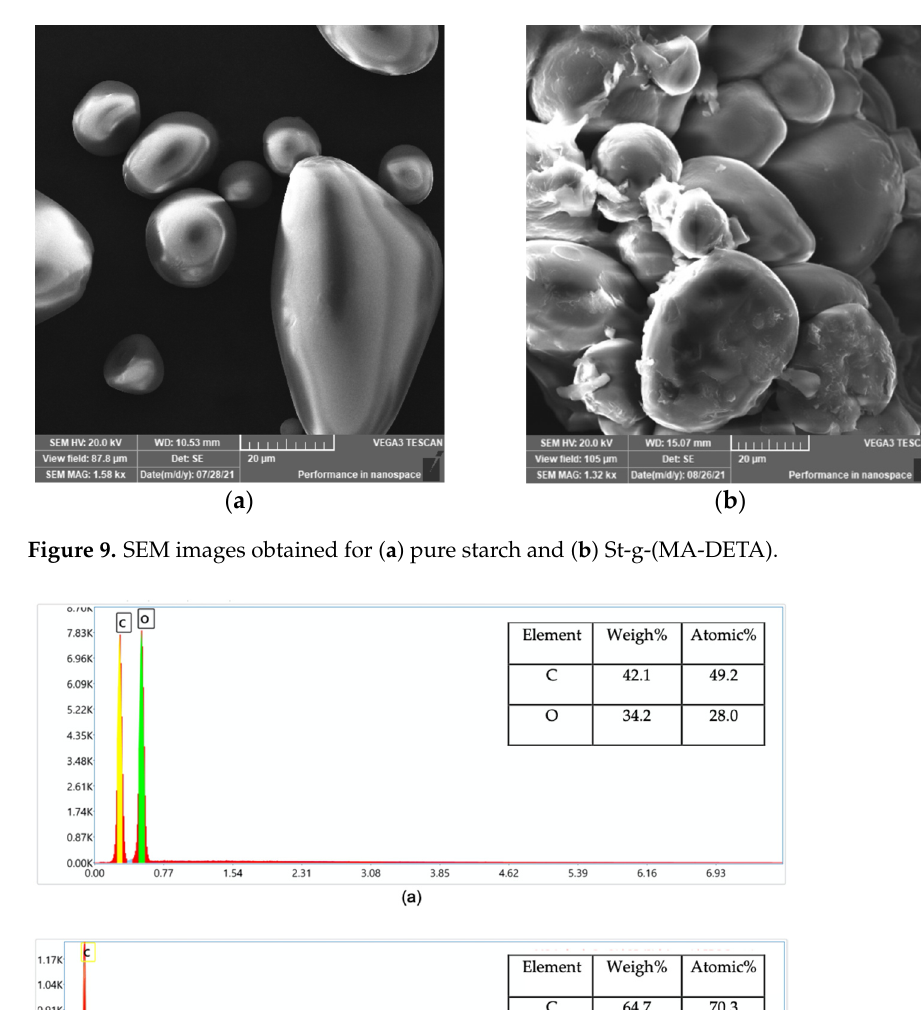
Figure 9. SEM images obtained for ( a ) pure starch and ( b ) St-g-(MA-DETA).